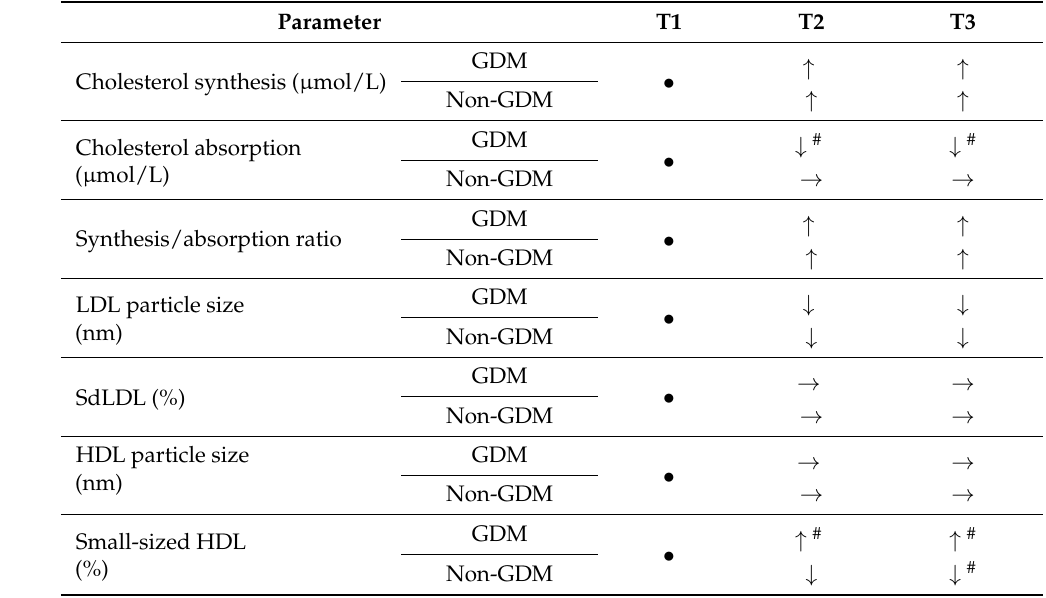
Table 6. Directions of changes of advanced lipid profile across